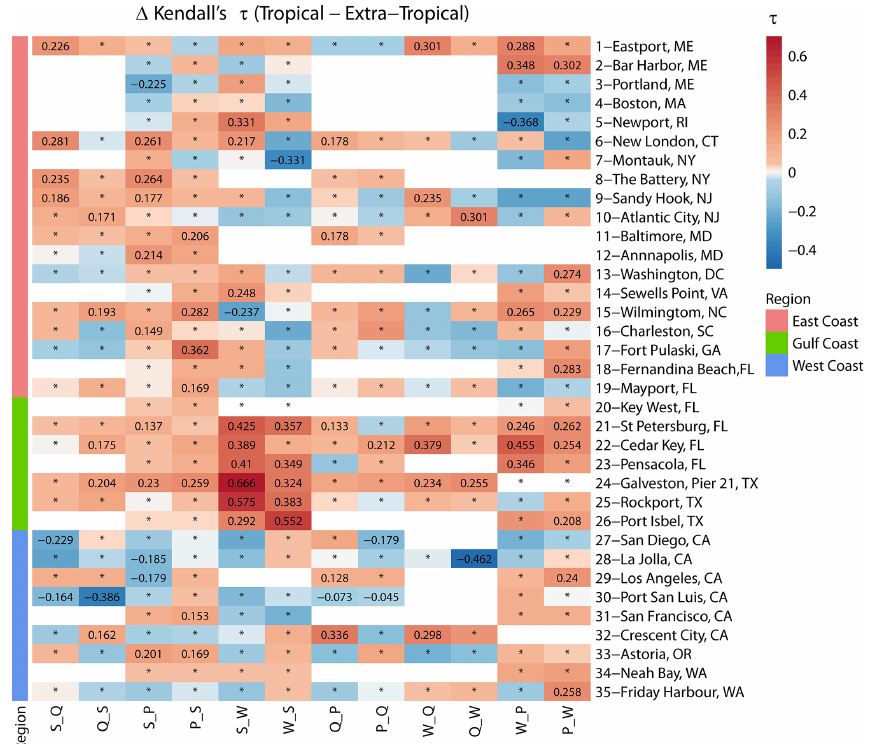
Figure 6. Heat map showing differences in Kendall’s τ derived from two-way sampling, using seasonal maxima approach for tropical and extra-tropical seasons. Sites are grouped into locations on the East, Gulf, and West coasts (see colours on the left and in the legend). The colour bar denotes the difference between τ in the tropical versus extra-tropical season, where the red colour denotes higher dependence in the tropical season, and the blue colour denotes higher dependence in the extra-tropical season. Squares with an asterisk ( ∗ ) indicate that the difference in dependence across seasons is not significant. Blank squares indicate that data for the particular pair did not exist or that the number of overlapping years was less than